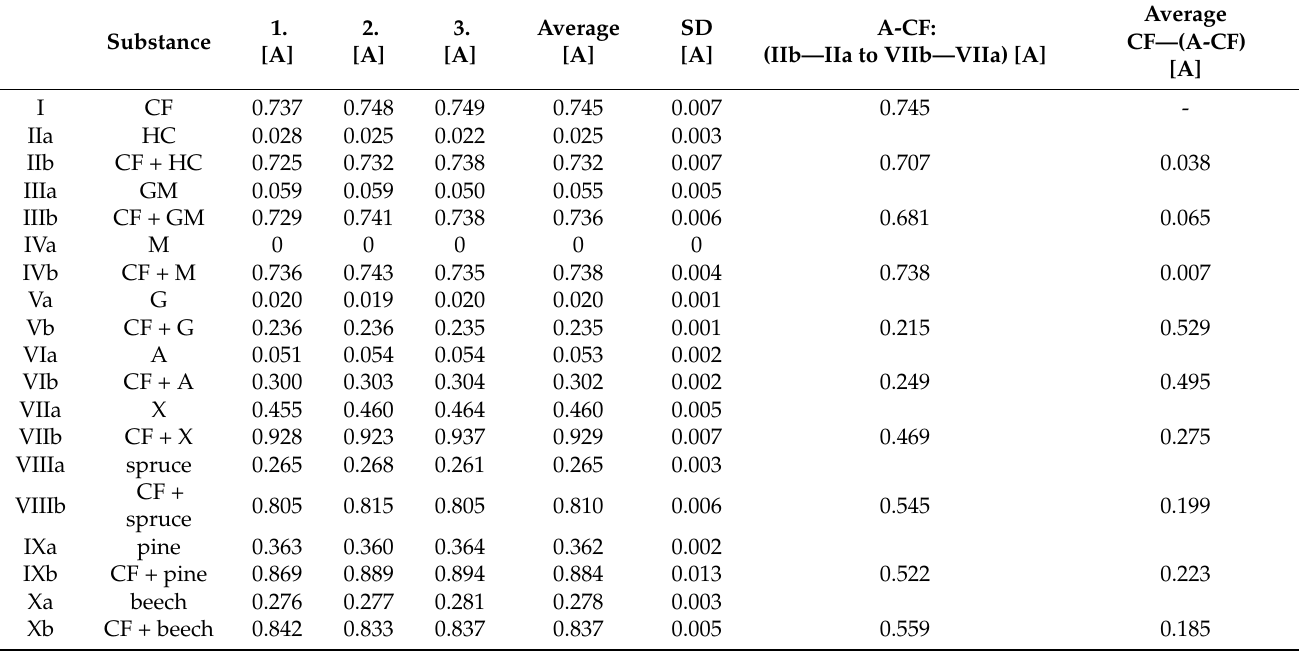
Table 1. Absorbance of tested samples at λ = 287 nm: caffeine (CF), hemicellulose (HC), galactomannan (GM: D-mannose + D-glucose + D-galactose in ratio = 3:1:1), mannan (M), galactan (GT), glucose (G), arabinose (A), xylan (X), spruce (mannan: xylan ratio = 5:3), pine (mannan: xylan ratio = 1:1) and beech (mannan: xylan ratio = 1:19). Primary data ( n = 3), mean values of absorbance [A] and their standard deviations